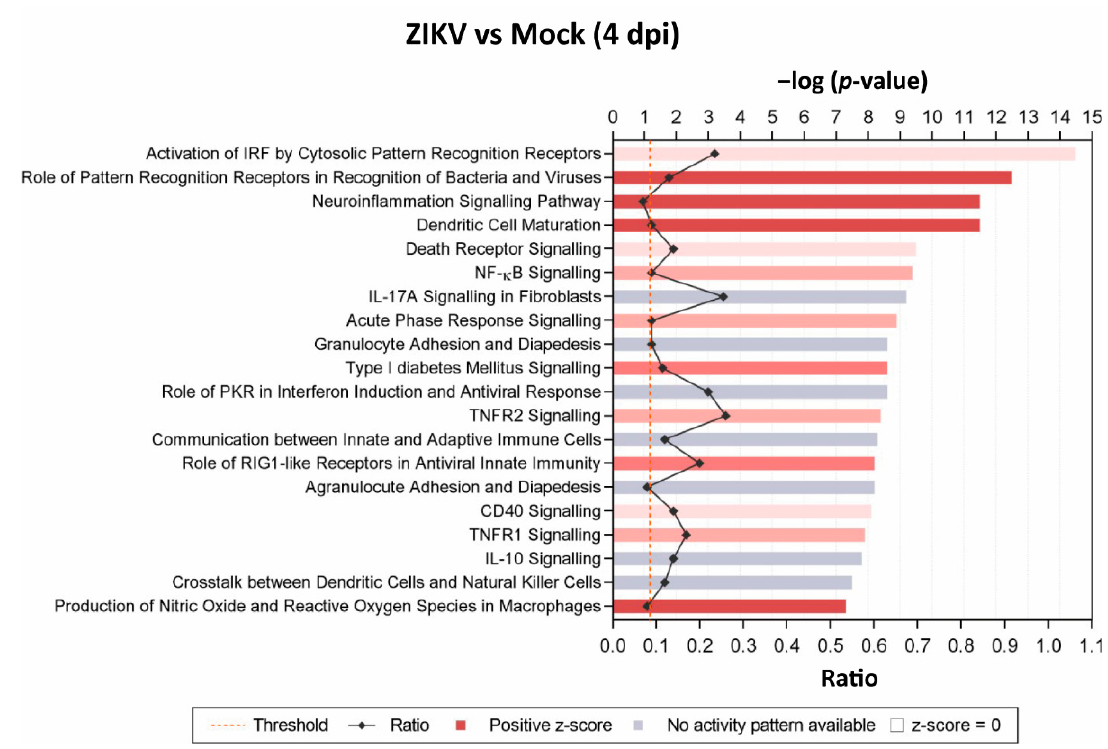
Figure 5. Identification of top 20 significant canonical pathways affected at 4 dpi in mature CNS cultures. Comparison of ZIKV-infected versus mock-infected mature mouse CNS culture by Ingenuity Pathway Analysis (IPA). Cellular pathways are indicated. Bars are measured against − log( p -values). The intensity of the color (red) correlates with z-score positivity. Positive z-scores indicate upregulated pathways, whereas negative z-scores are indicative of downregulation. Gray bars indicate that although a pathway is affected, the resulting activity (activation or repression) is unknown. The ratio reflects the number of molecules presented in the dataset that are involved in each pathway against the known total of pathway components.